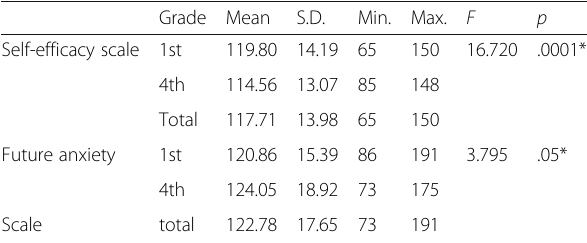
Table 6 Comparing grades (the 1st and 4th year) as regards both future anxiety and self-efficacy Grade Mean